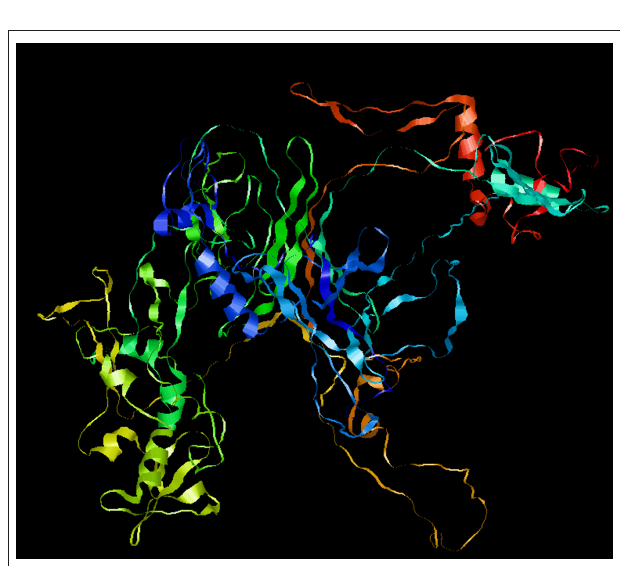
FIGURE 3 | Refinement of the SARS-CoV-2 vaccine construct. Representative 3D image of the tertiary structure of the 2019nCOV vaccine after modeling.